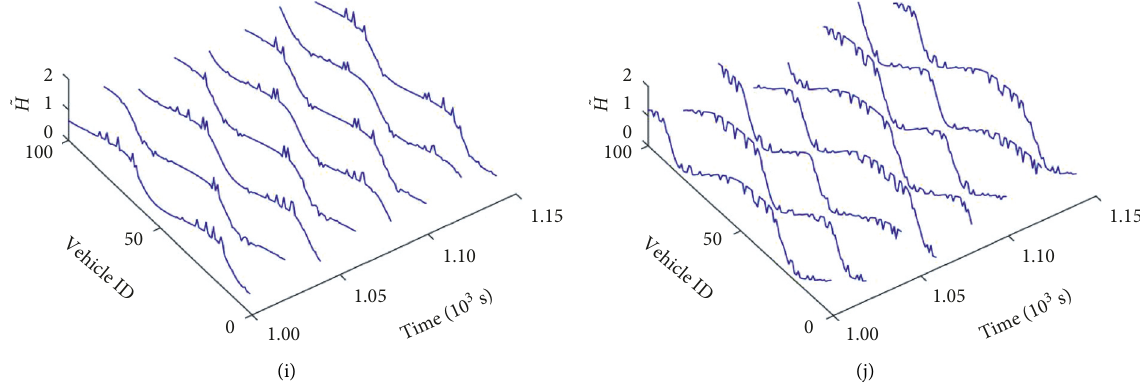
Figure 9: Space-time evolution of the headway under communication failures. (a) p � 0 . 1 , q � 0 . 2. (b) p � 0 . 1 ,q � 0 . 8. (c) p � 0 . 3 ,q � 0 . 2. (d) p � 0 . 3 ,q � 0 . 8. (e) p � 0 . 5 ,q � 0 . 2. (f) p � 0 . 5 ,q � 0 . 8. (g) p � 0 . 7 ,q � 0 . 2. (h) p � 0 . 7 ,q � 0 . 8. (i) p � 0 . 9 ,q � 0 . 2. (j) p � 0 . 9 ,q � 0 . 8.